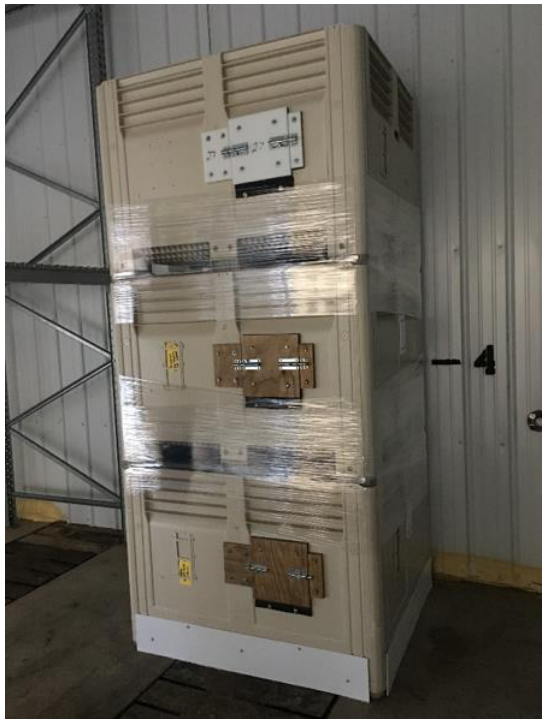
Figure 1. Large plastic totes used for holding potatoes for each variety / treatment were placed top of each other during storage.